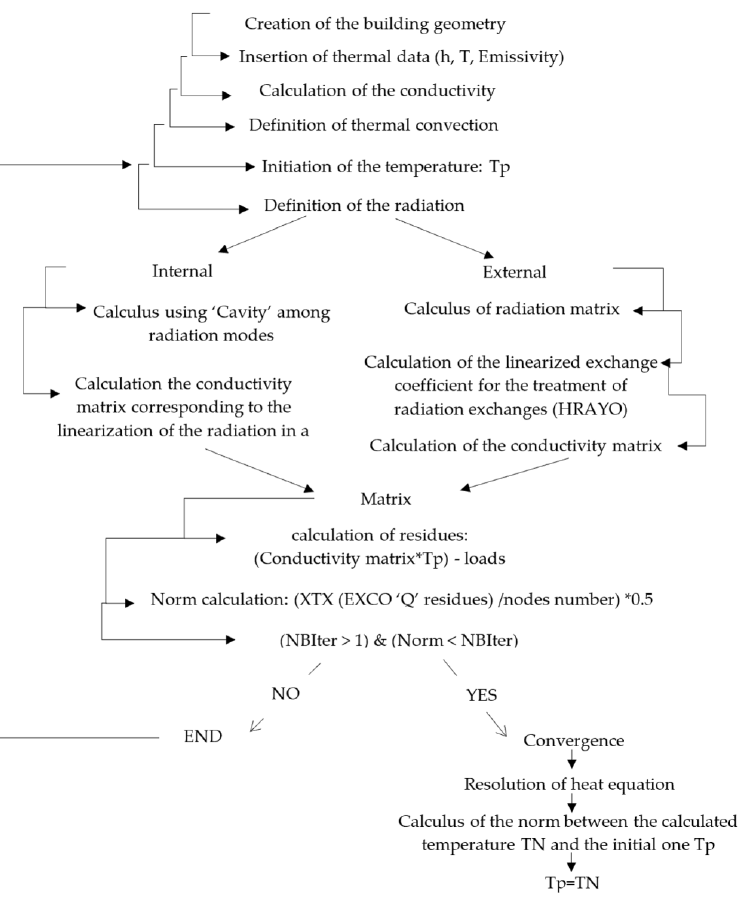
Figure 5. Algorithm for heat transfer computation and linearization process on Cast3m.